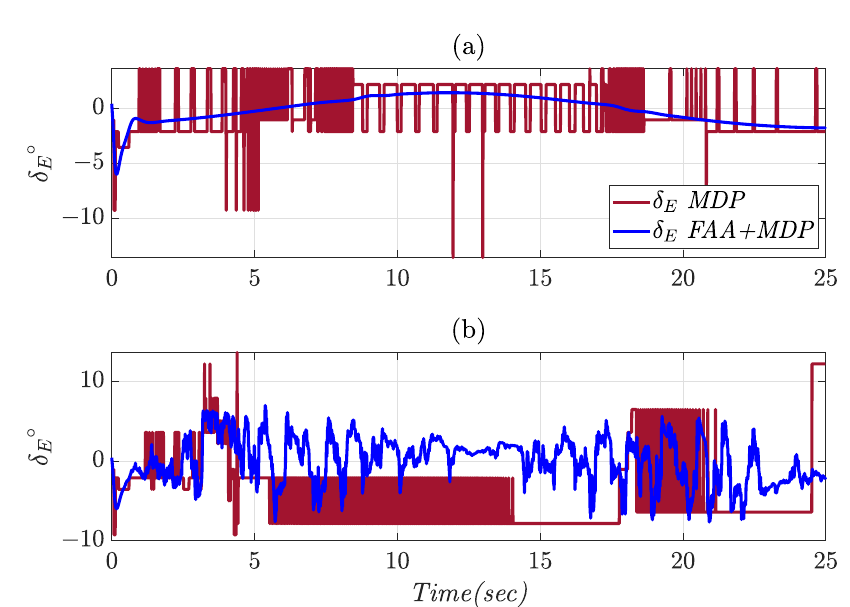
Figure 9. Elevator deflections in variable θ tracking ( a ) in ideal conditions, ( b ) in the presence of sensor measurement noises and atmospheric disturbances.